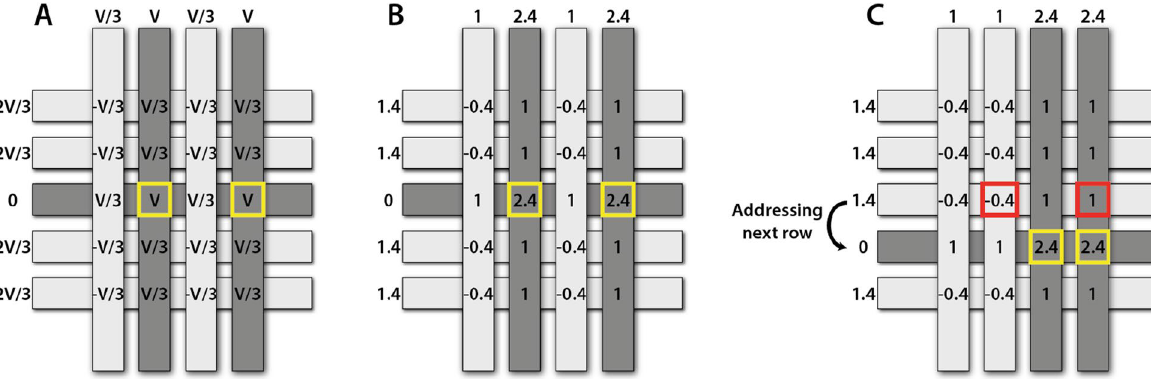
Figure 4. The V/3 addressing protocol is used to update screen printed PMADs, here exemplified by a 5 × 4 display architecture. ( A ) Strictly following the V/3 protocol results in ± V/3 in non-addressed PMAD pixels, which in turn would generate cross-talk effects for the pixel architecture presented herein. ( B ) An optimized addressing protocol, still relying on the V/3 addressing method, is used to update the PMADs. The voltage amplitudes are skewed due to the non-symmetric pixel switching response; approximately 1 V and -0.5 V is required to initialize the reduction and oxidation of the PEDOT:PSS-based pixel electrodes, respectively. ( C ) The PMADs are updated row by row, and the schematic illustrates a part of an updating sequence when shifting from row 3 to row 4. As an example, the pixels in columns 2 and 4 are updated when row 3 is addressed, as indicated by the red squares in row 3. Once this has been completed, the row addressing is shifted to the subsequent row, and an arbitrary number of pixels can be updated in the currently addressed row, here exemplified by applying the voltage V (2.4 V) to columns 3 and 4. The colored pixels in previously addressed rows retain their color since the resulting voltages in non-addressed pixels remain below the threshold voltages. The yellow squares in the schematics illustrate pixels currently being addressed. The currently addressed row and columns are indicated by dark gray color in the